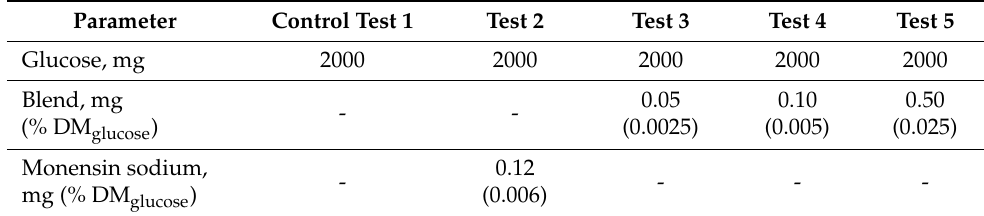
Table 2. Experimental protocol for assay 2 (liquid pure form